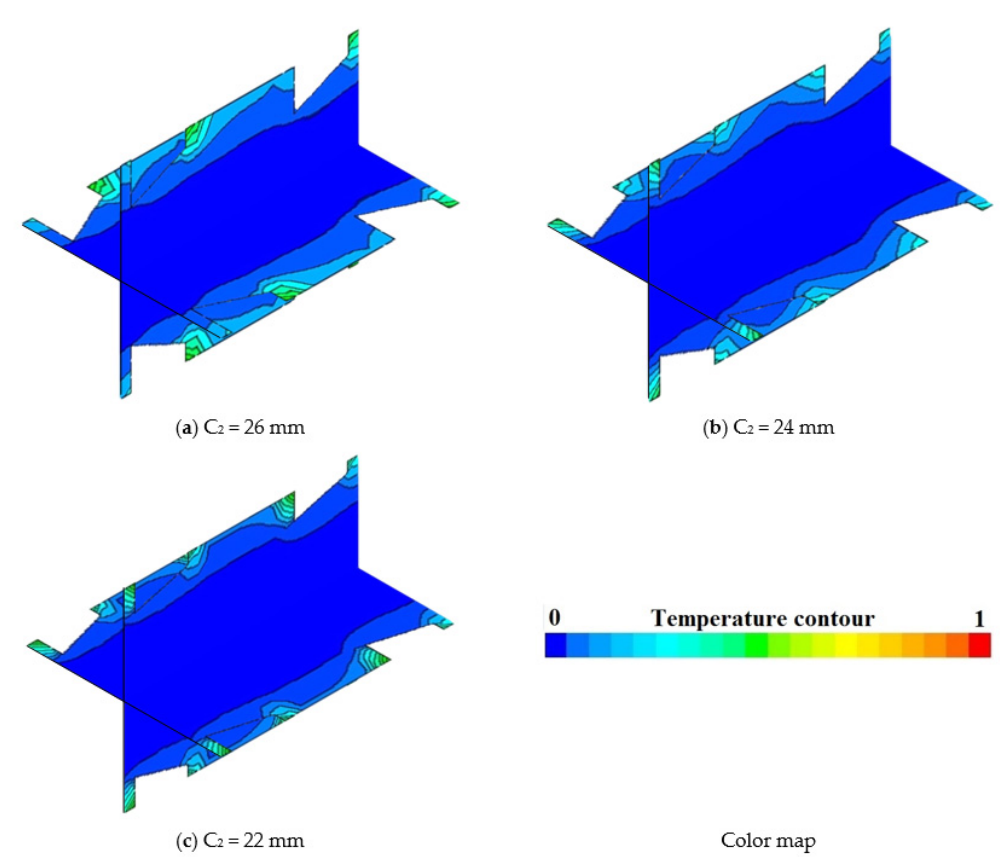
Figure 23. Temperature contours for various configurations of Case C with different C 2 parameters at R = 15 mm, Re = 15,000, and ϕ =